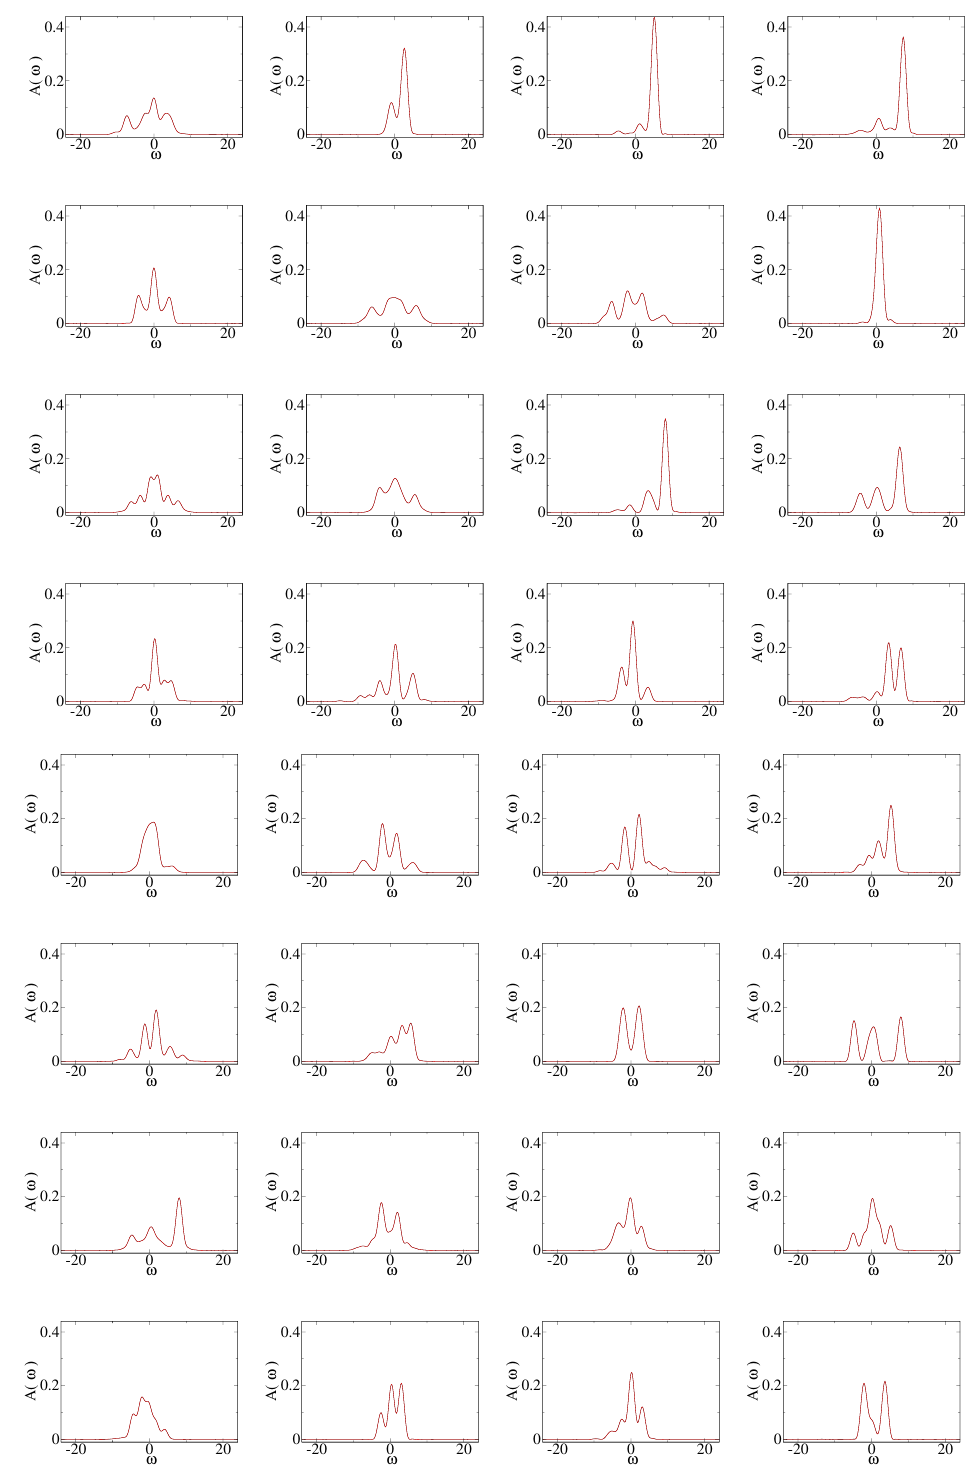
Figure 3. The spectral function, A ( ω ) , is plotted for the same 32 randomly chosen parameter sets used in Figure 2. Both the results from the KPM and from the neural network are shown. They match each other very closely and visually overlap. A closer inspection reveals that there are slight oscillations in the spectral function when the weights are very small. This may be due to the inexact cancellations of different orders in the coefficients generated by the neural network method. In general, these oscillations are rather small and only appear when the spectral weight drops to near